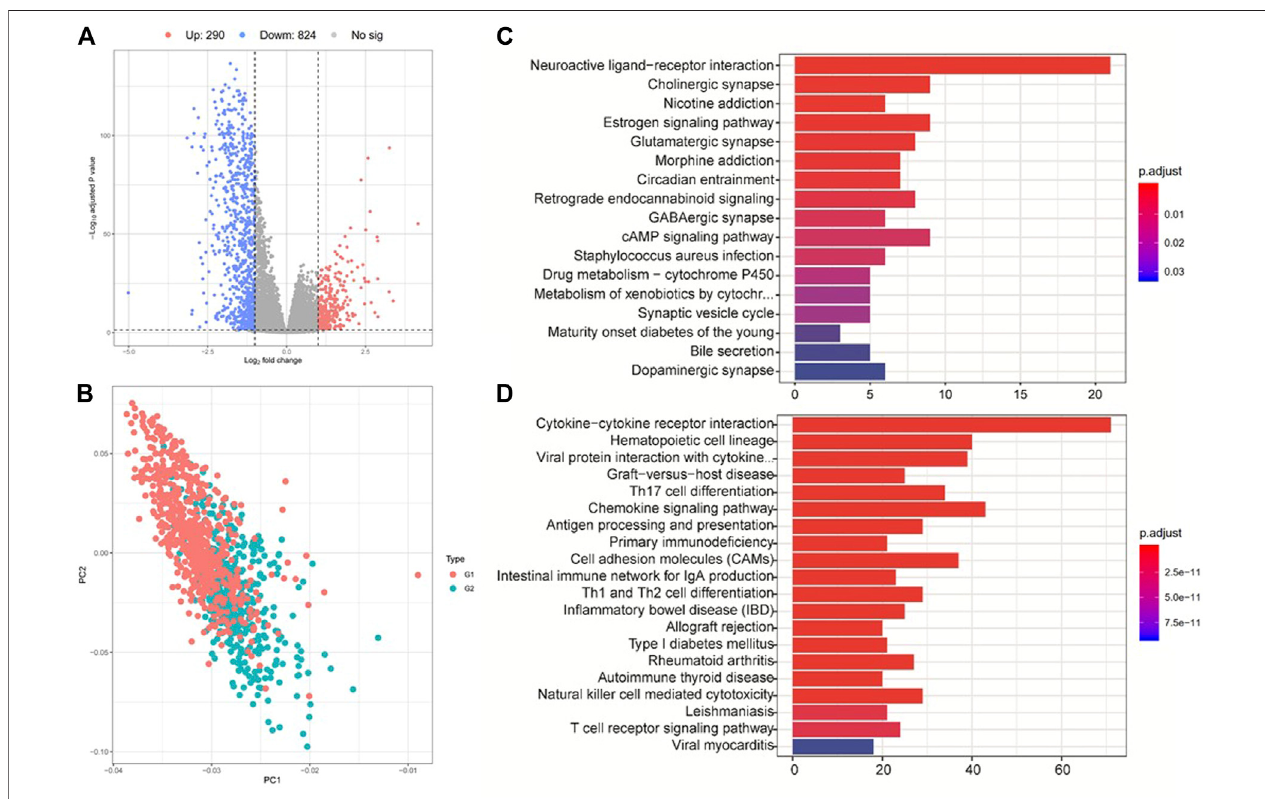
FIGURE4| Analysisofdifferentiallyexpressed genesandtheircorresponding pathways. (A) Geneexpression differencesbetweengroup2(G2)andgroup1(G1). (B) PCA analysis shows the clustering results of group 2 (G2) and group 1 (G1). (C) and (D) KEGG pathway enrichment analysis for the up- (up panel) and down- regulated (down panel) genes between G2 and G1